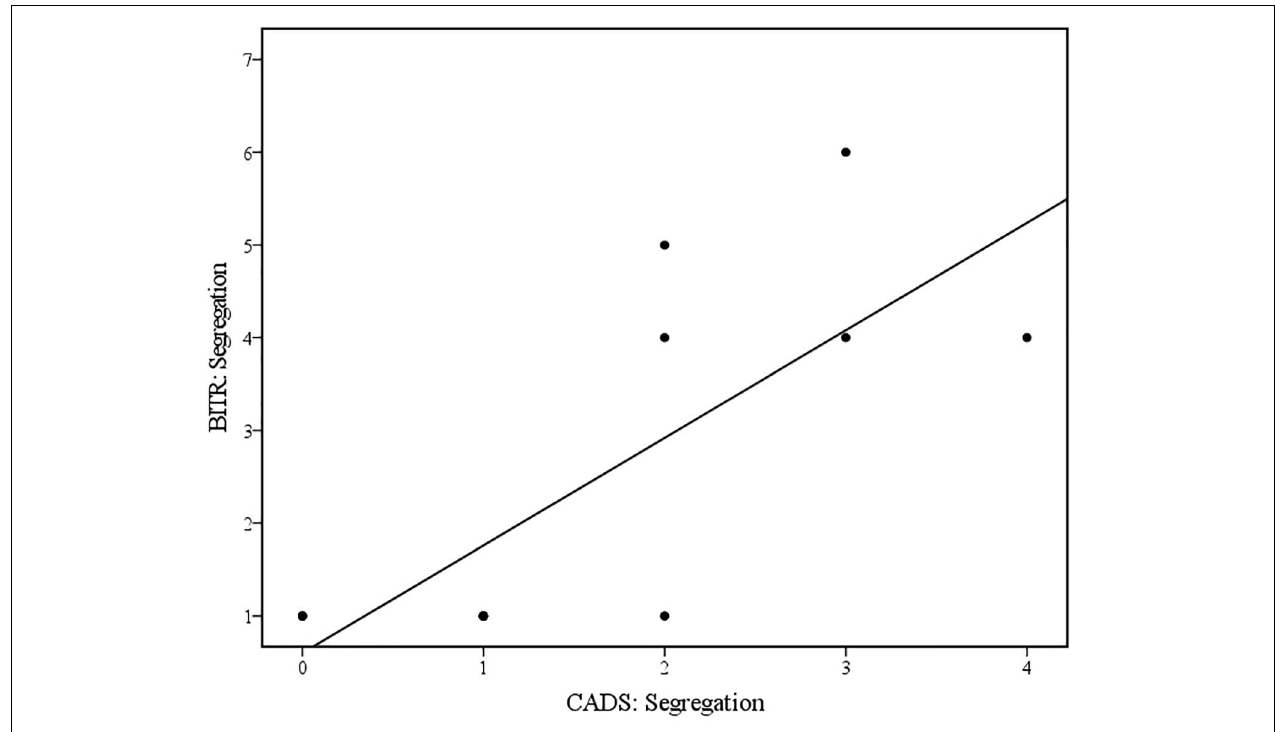
FIGURE 4 | Scatterplot and line of best fit (linear) illustrating the relationship between Segregation (Trauma) in Bumps in the Road (BITR: Segregation), and Segregation as measured by CADS (CADS: Segregation) ( N = 13) (Linear equation: y = 0.6+1.16 × ; R 2 = 0.60).